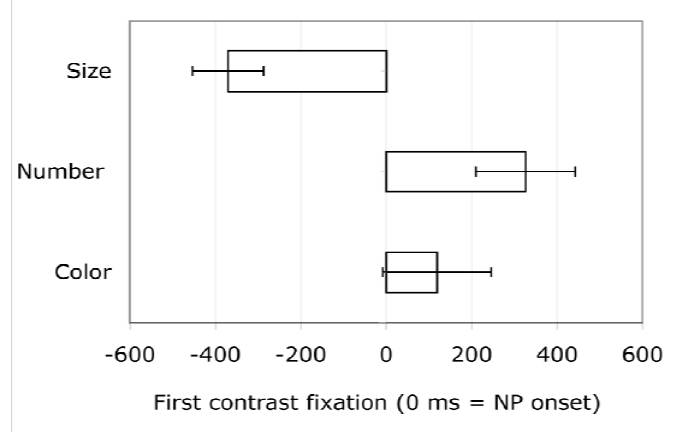
Figure 4. First contrast fixation times (ms relative to noun phrase onset) for fluent size-, number-, and color-modified